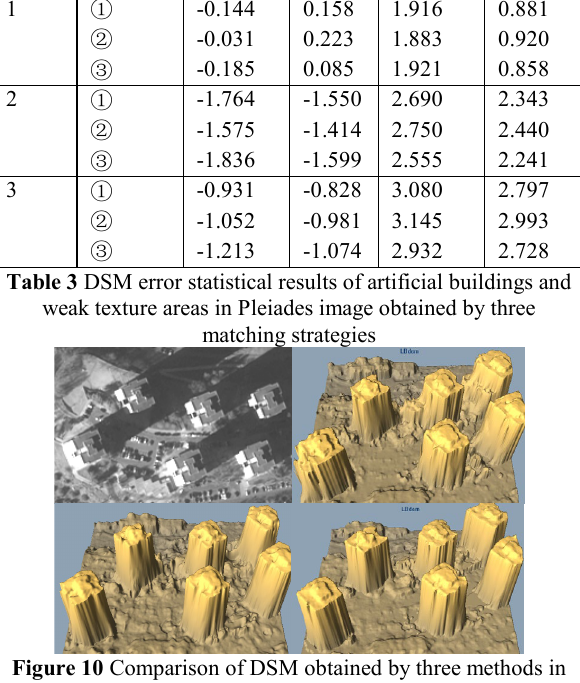
Figure 9 DSM error diagram of method ③ in three regions.